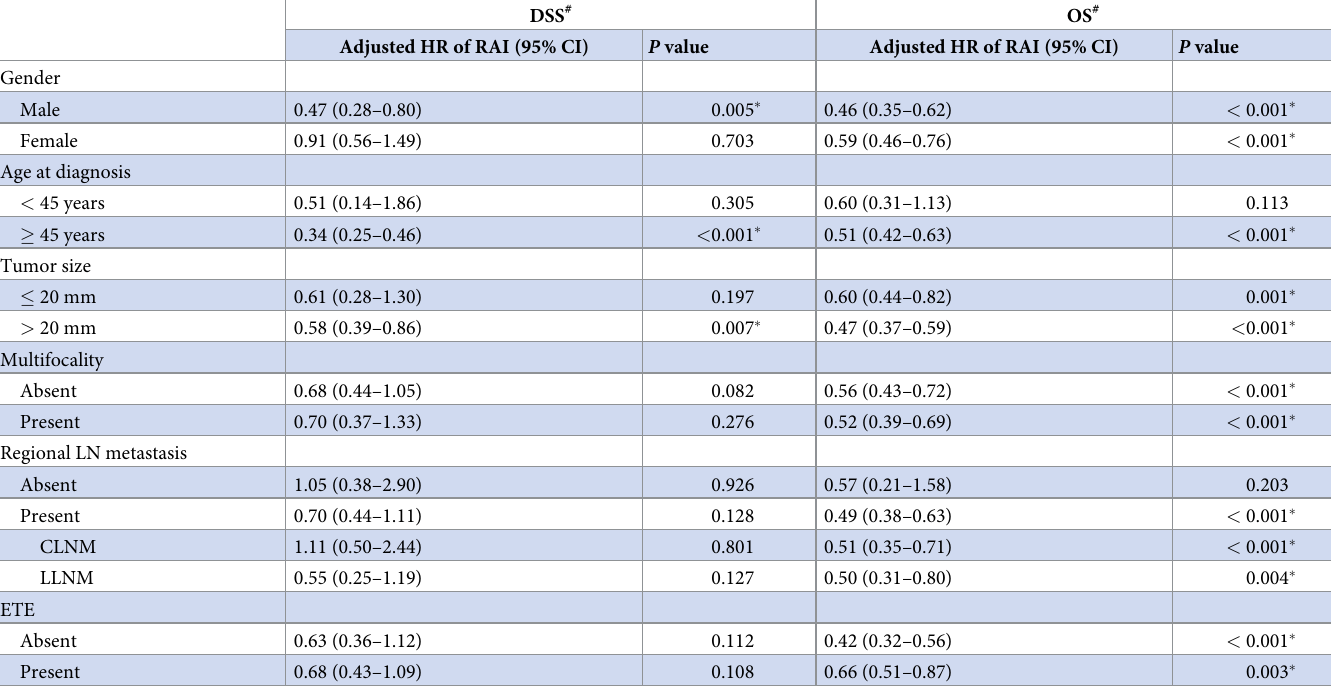
Table 3. Subgroup analyses of the impact of RAI on DSS or OS in intermediate risk PTC